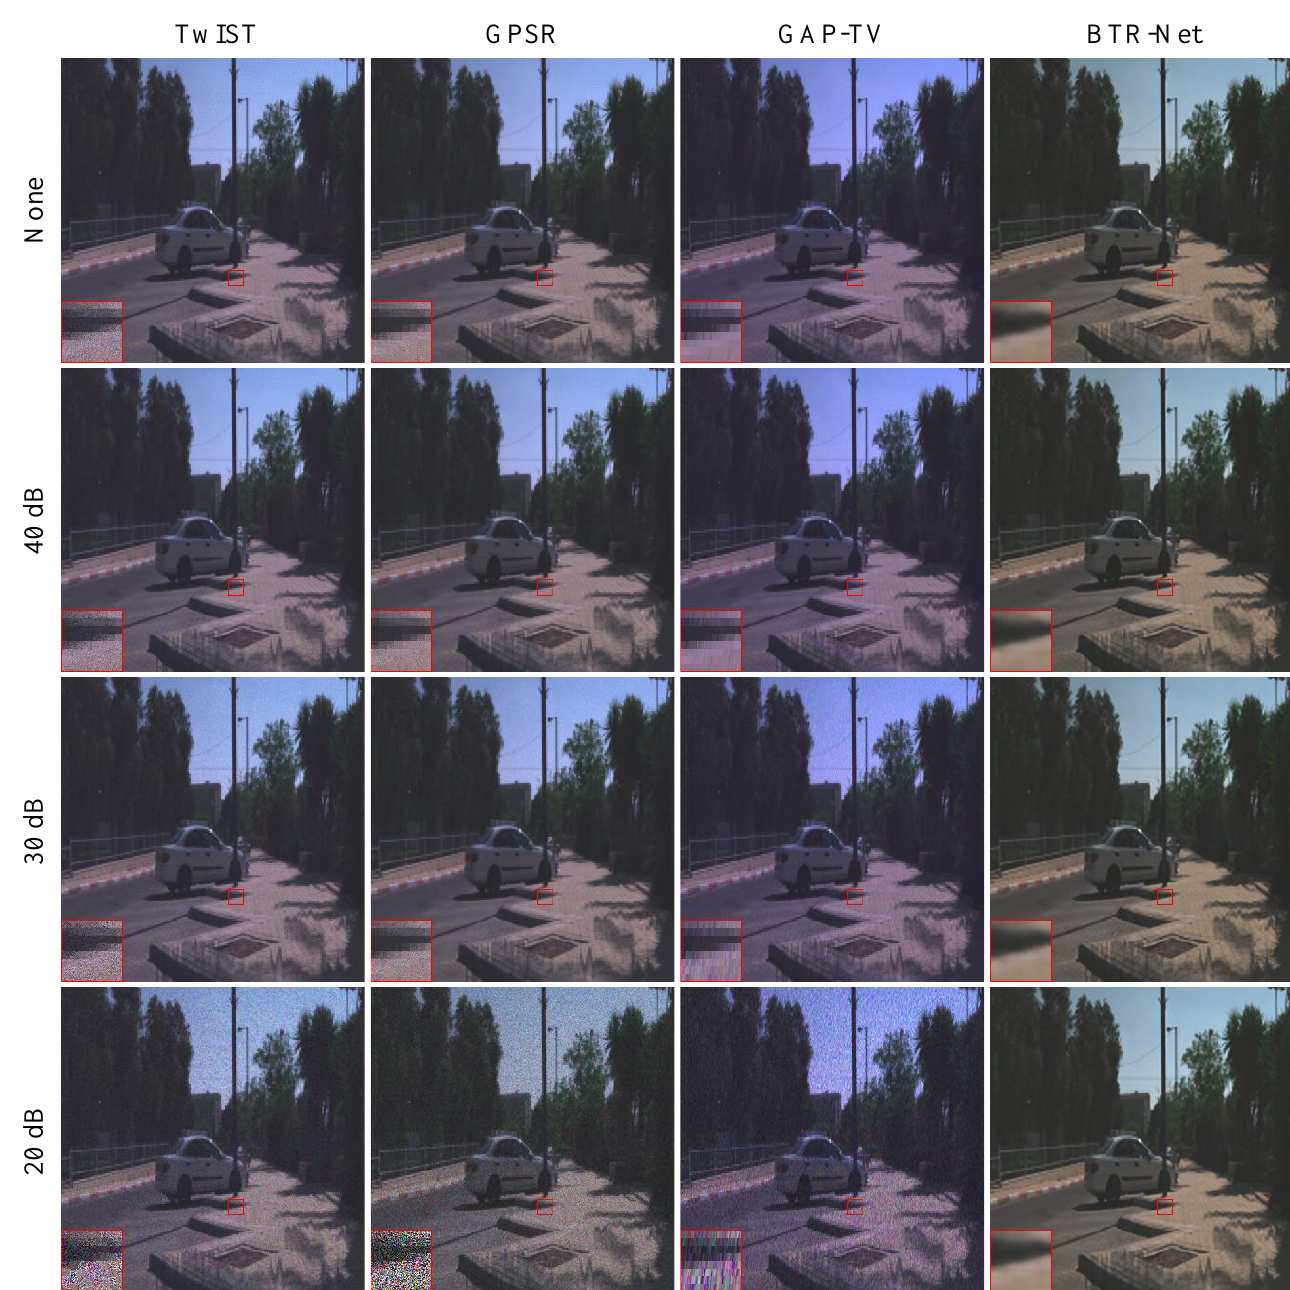
Figure 7. Visual quality comparisons of reconstructed results at different noise levels.